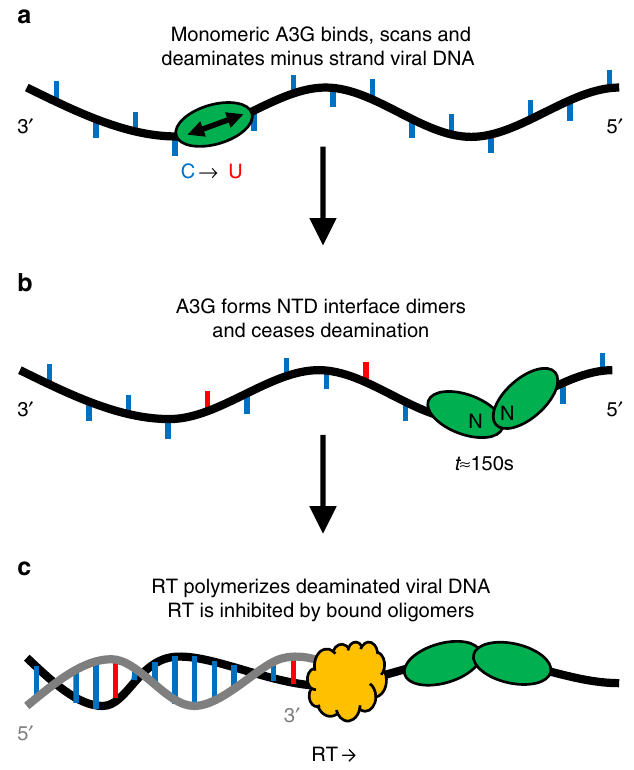
Fig. 8 Schematic of two mode inhibition of HIV-1 replication by A3G. a Monomers bind and slide along the minus strand viral DNA, allowing for rapid deamination. b After ~150 s, bound A3G monomers form dimers through NTD interactions. Dimers do not slide along ssDNA, inhibiting catalytic activity. c RT polymerizes the complementary plus strand viral DNA, including G to A substitutions at sites of deamination. The formation of the full plus strand is also inhibited by bound A3G